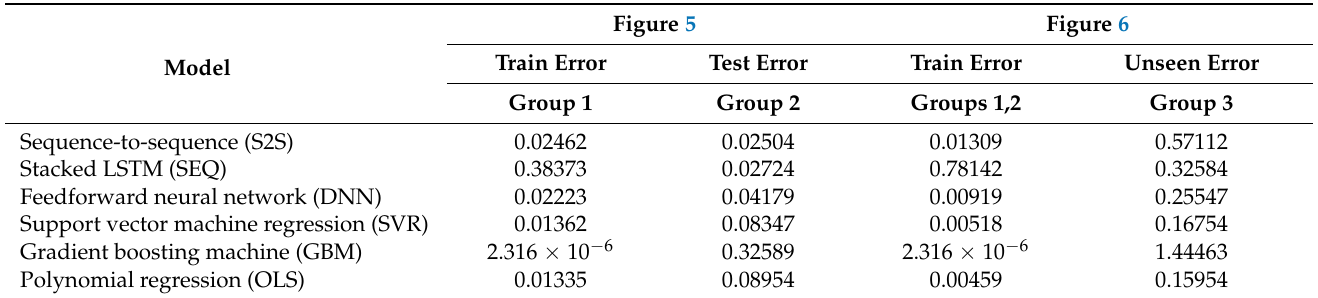
Table 2. Training and testing errors given by mean squared error (MSE) of different models con- structed using different feature